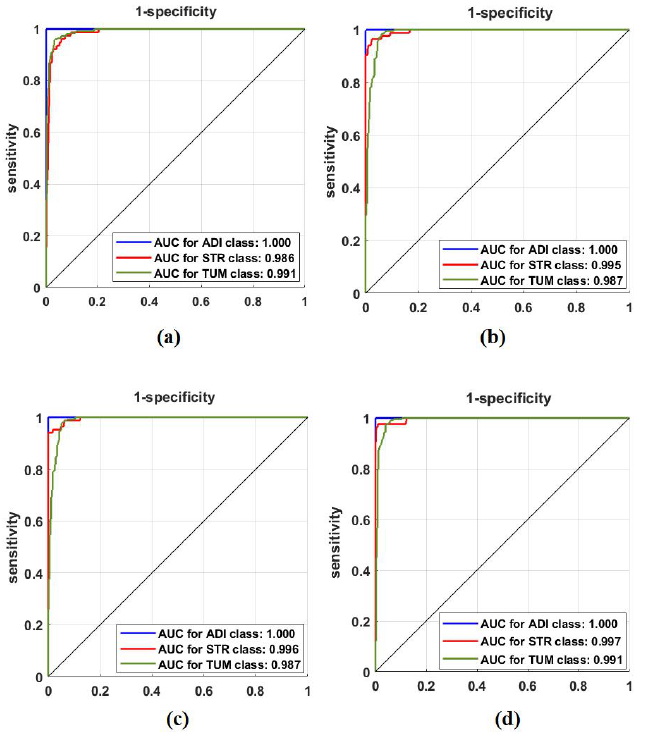
Figure 9. ROC analysis of the CRC test set obtained by: ( a ) ResNet-50 pre-trained network, ( b ) DeTraC, ( c ) 4S-DT , and ( d ) XDecompo